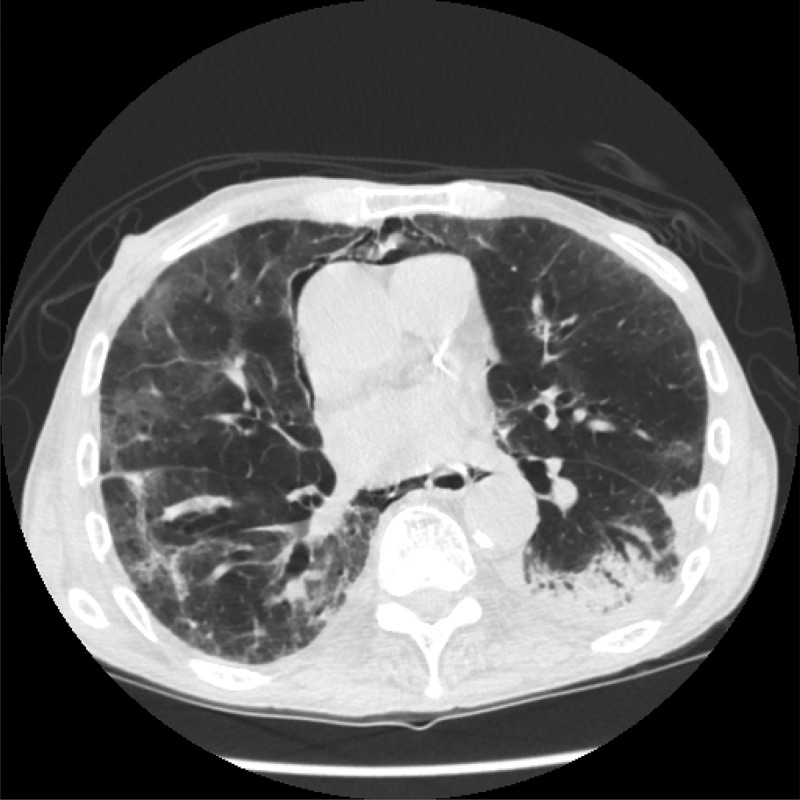
CT scan of chest showing improved opacity of lung parenchyma 2 weeks after discontinuation of daptomycin.